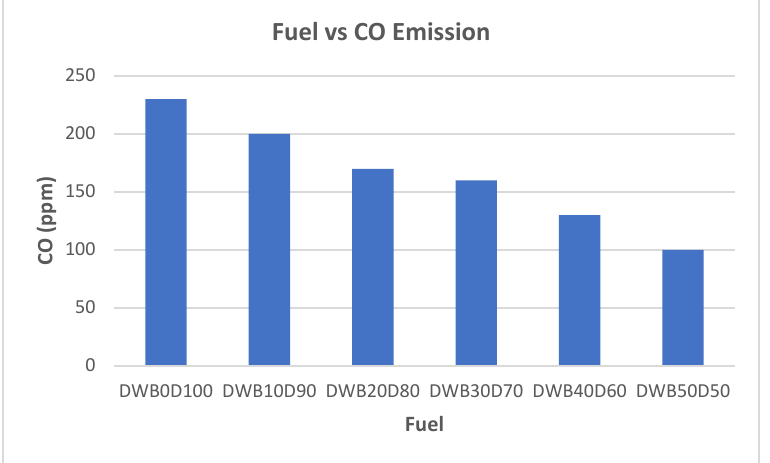
Figure 9. CO emission from engine using diesel and diesel blended with distilled WCO biodiesel.